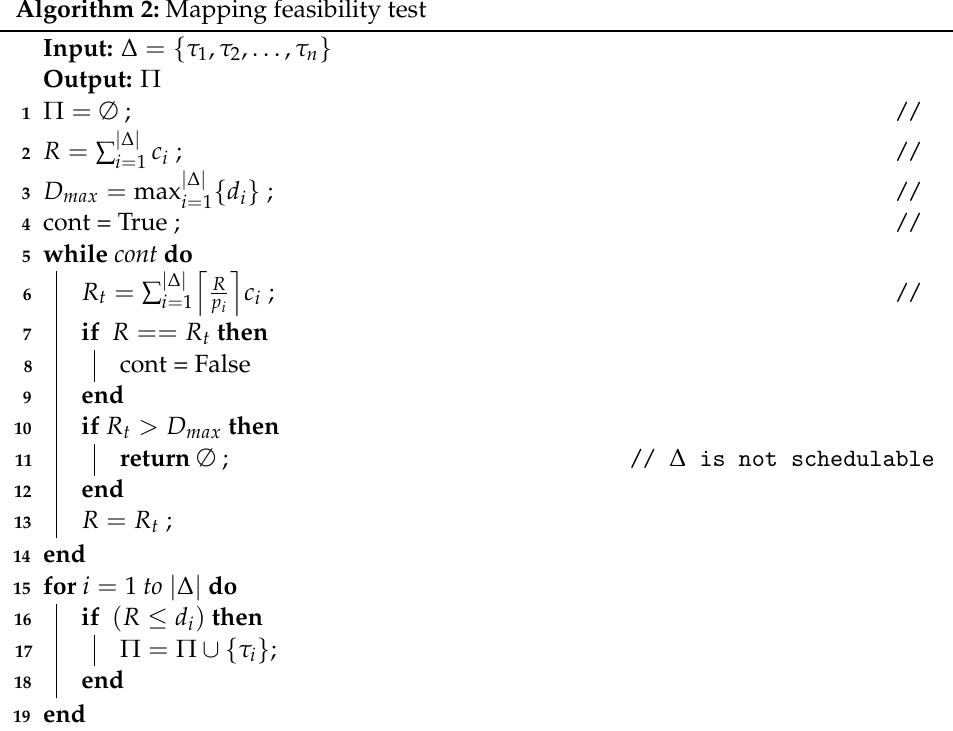
Algorithm 2: Mapping feasibility